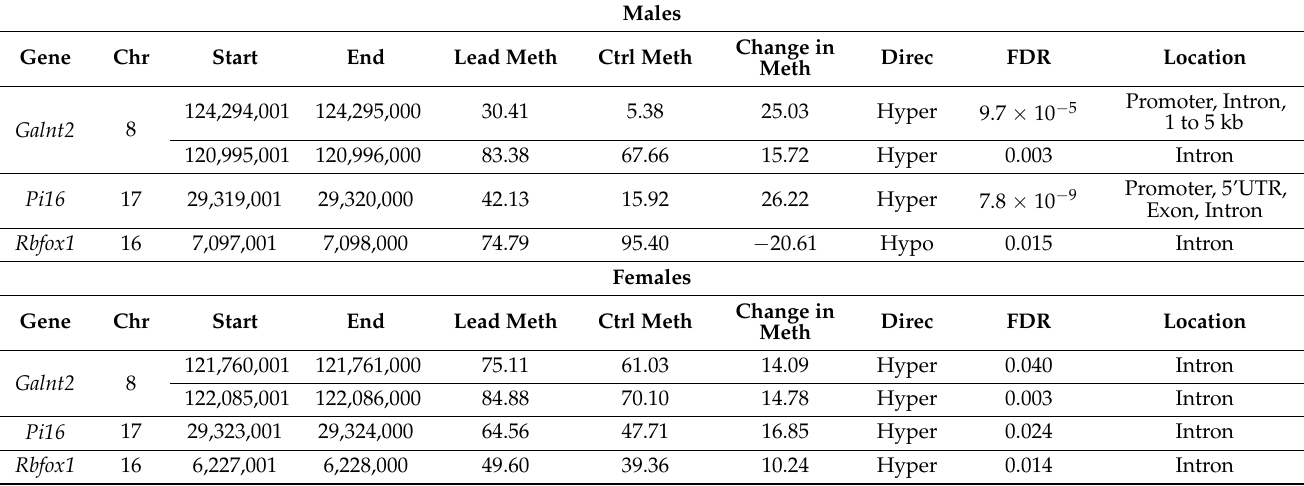
Table 5. DNA methylation changes at DMRs in cardiovascular disease-associated genes that overlap between males and females.